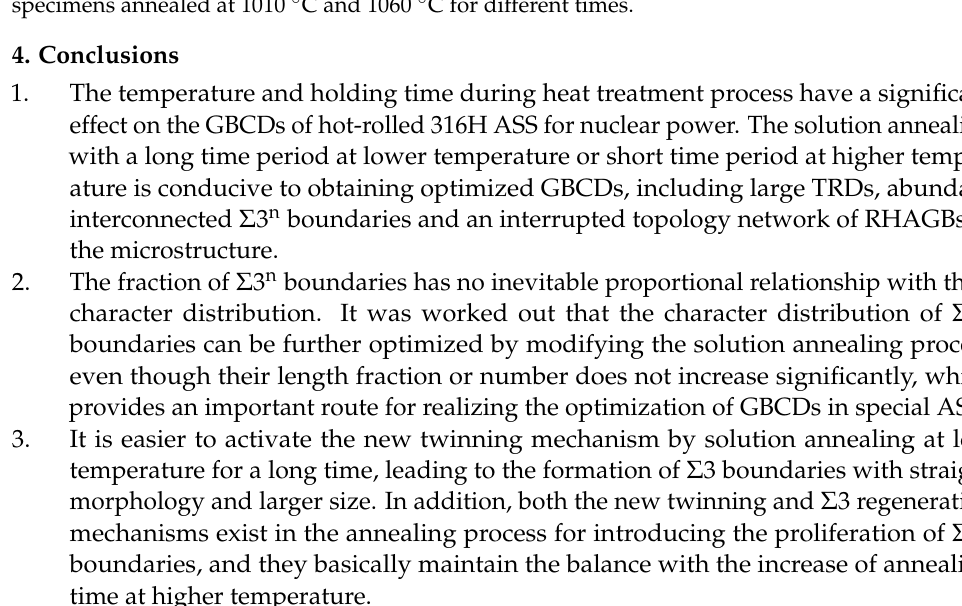
Figure 6. Variation of length fractions for Σ3 n boundaries (Σ3, Σ9 + Σ27 and Σ3/(Σ9 + Σ27) ratio) at specimens annealed at 1010 °C and 1060 °C for different times.